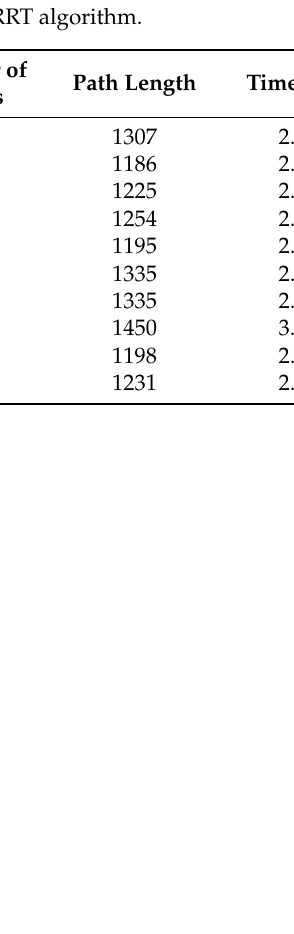
Figure 13. Comparison of the number of nodes produced by the two algorithms and their mean and median.